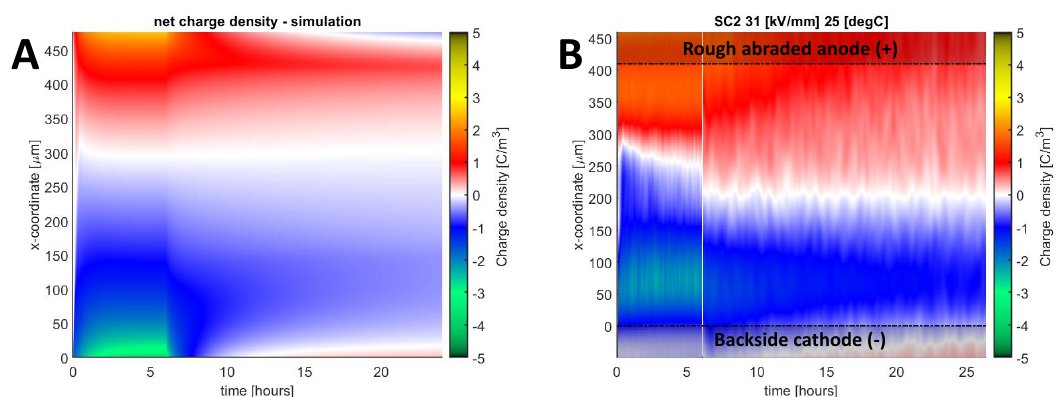
Figure 9. Colormap of net space charge density obtained in simulation ( A ) and in measurement ( B ) for sample SC-2 subjected to 15 kV biasing voltage at 25 °C.